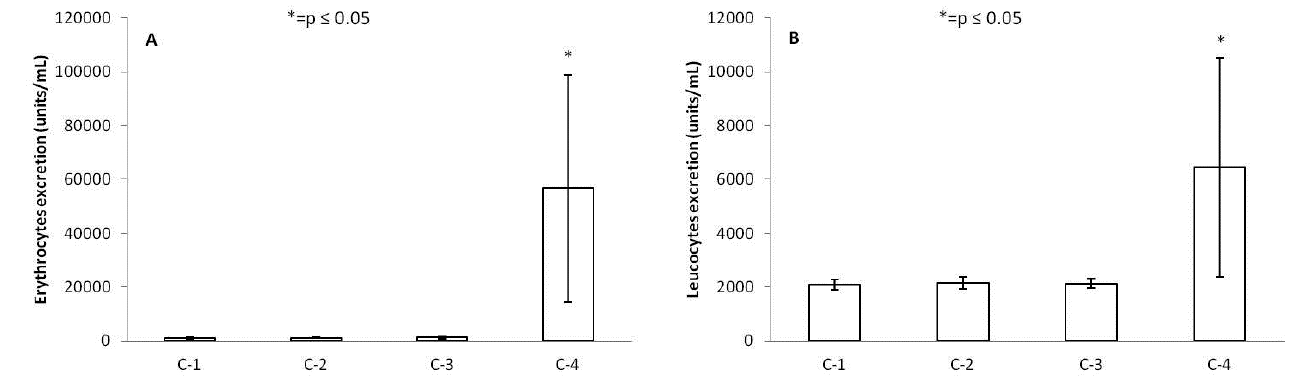
Figure 2. Erythrocytes count in units/mL (1A) and leucocytes count in units/mL (1B) before (C-1), during the training program (C-2), before (C-3) and after the competition (C-4). * = p < .05.